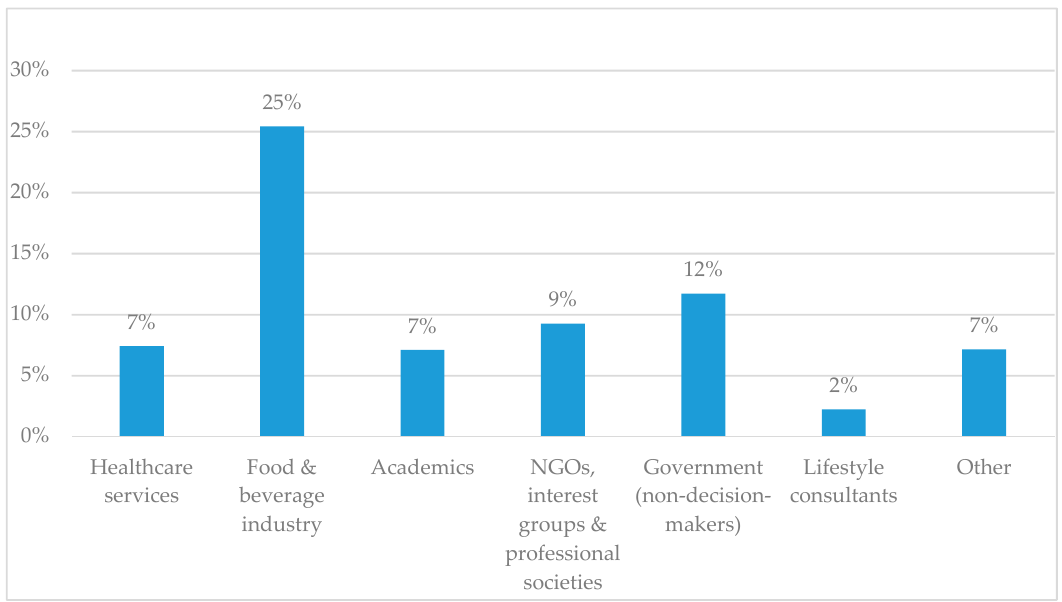
Media direct relationships with decision-makers as share of total relationship of the professional